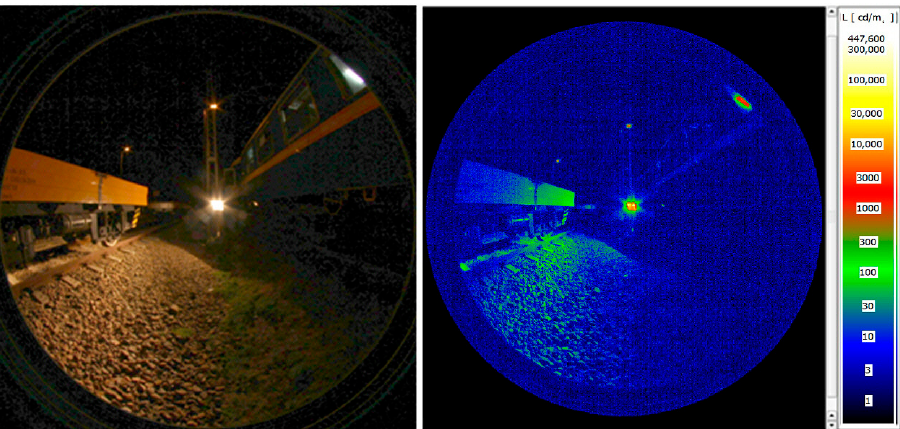
Figure 5. The view from the measurement point with corresponding luminance map. Measured GR = 79, subjective sensation of glare: unbearable, task of activity [5]: Freight track, continuous operations, GR MAX from standard [5] = 50. In this case, the location of the glare source determined the high level of glare (high GR value). The glare source is in the field of view very close to the line of sight. According to the formula of GR [40], the value of this index is inversely proportional to the square of the angle between the observer’s line of sight and the direction to the glare source.